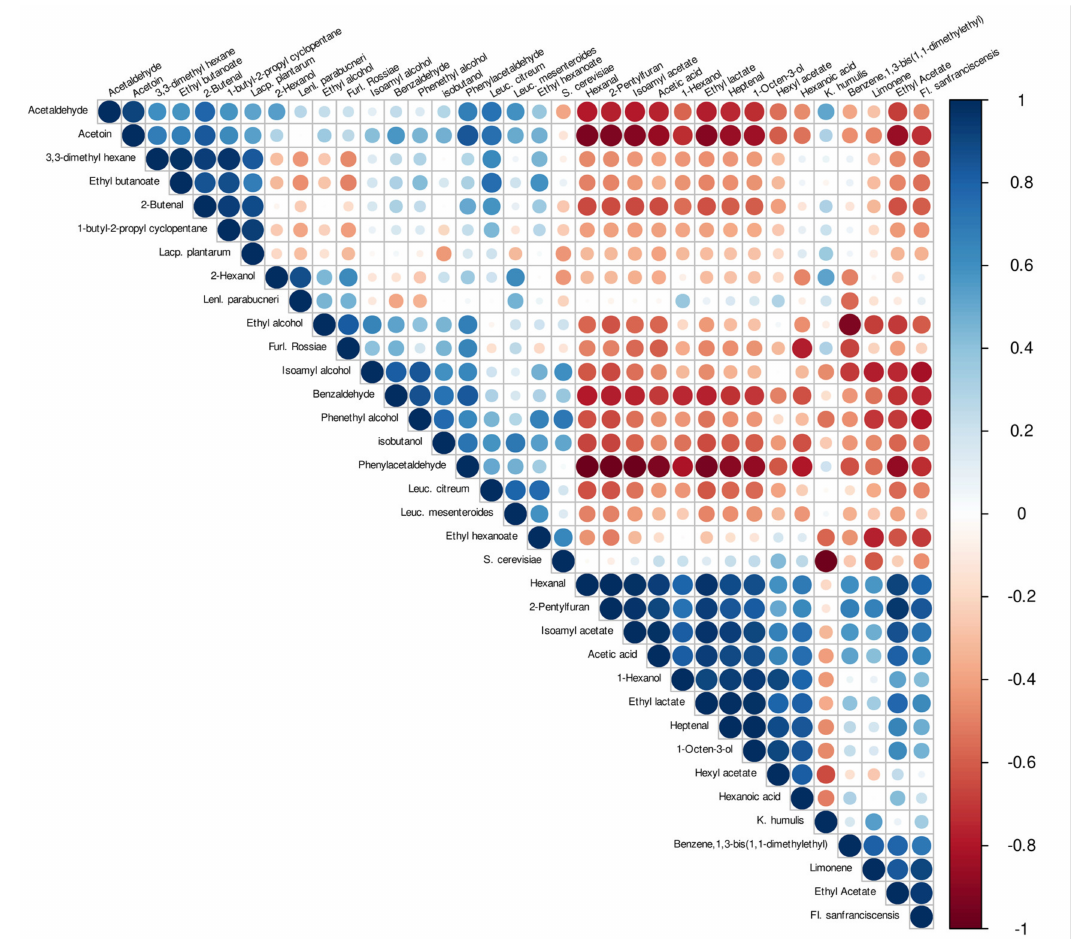
Figure 8. Correlation plot among discovered VOCs and isolated species, obtained using R package Corrplot and Pearson’s correlation index. The positive and negative correlation were considered based on R 2 ≥ 0.6 and R 2 ≤ − 0.6,